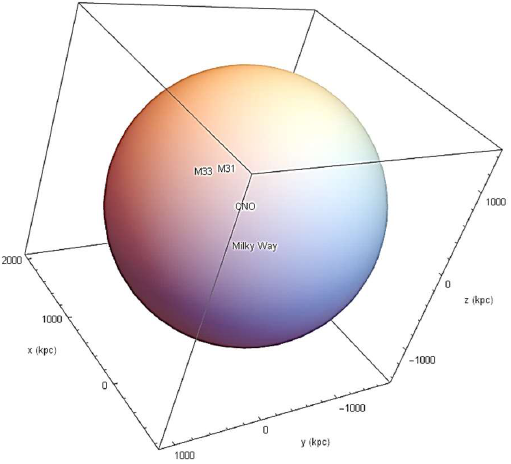
Figure 11. Plots the FORTRAN 3D solution bounding CNO with the locations of M31, M33 and the Milky Way.